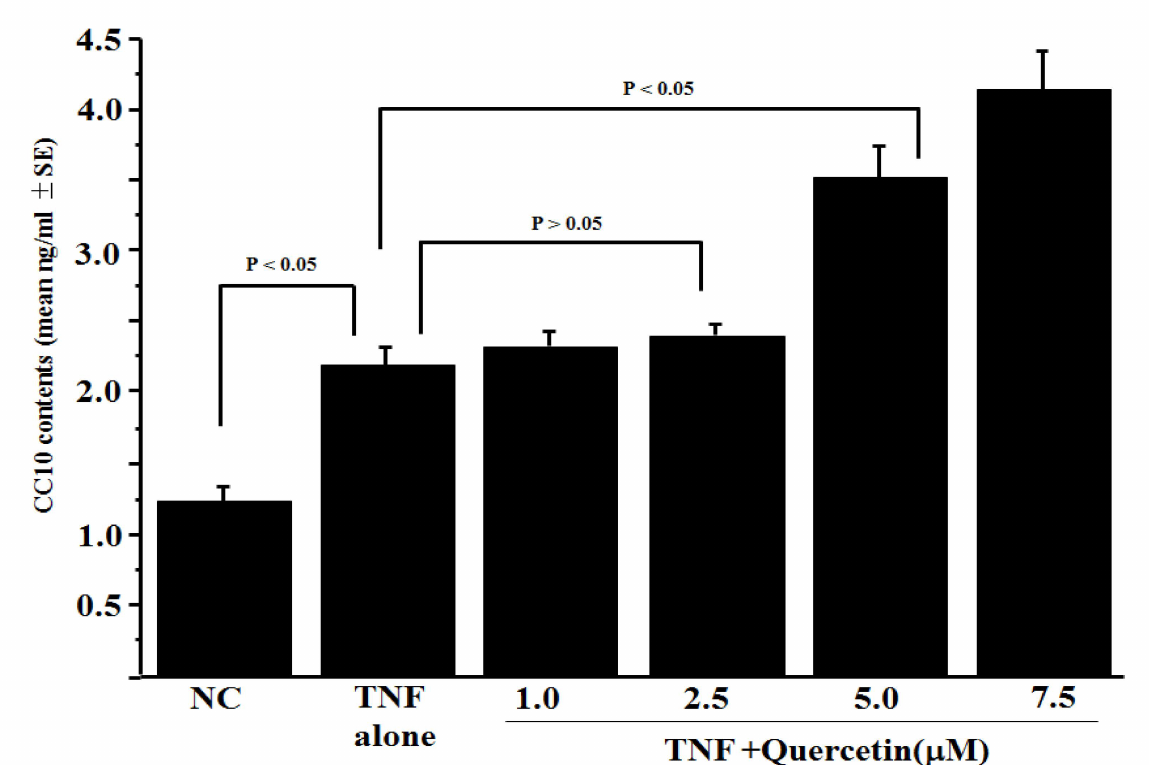
Figure 1. Influence of quercetin on CC10 production by HNEpCs in vitro. Human nasal epithelial cells (HNEpCs; 1 × 10 5 cells) were stimulated with 20 ng/mL of tumour necrosis factor-alpha (TNF) in the presence of quercetin. After 24 h, CC10 levels in culture supernatants were examined by ELISA. The data are expressed as the mean ng/mL ± SE of triplicate cultures. One representative of the two experiments is shown in this figure. NC: non-treated